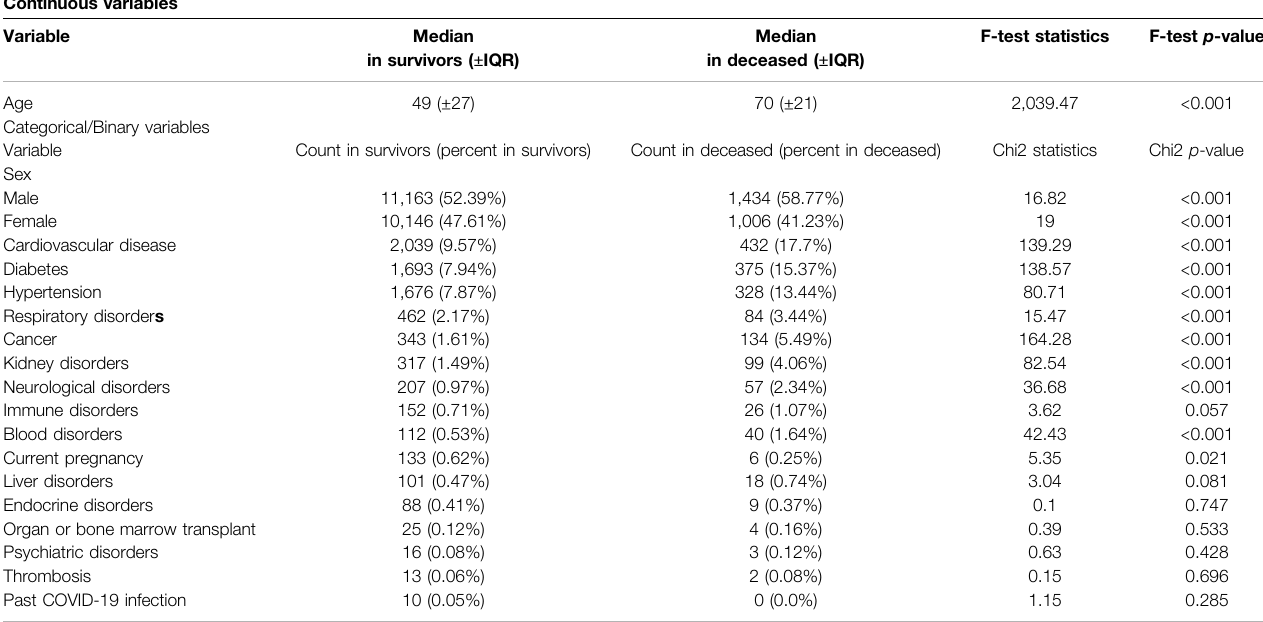
TABLE 3 | Comparison between survived and deceased patient groups. Comparative evaluation of the characteristics of survived and deceased COVID-19 patients.